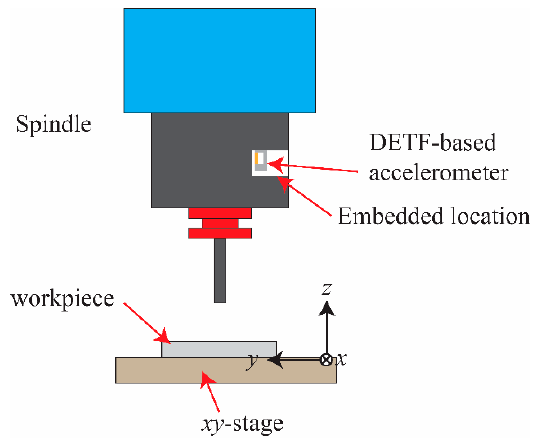
Figure 1. Illustration of installation of the double-ended tuning fork (DETF)-based accelerator on the smart spindle where the accelerations in the x - and y -directions could be measured for chatter detection and prediction.